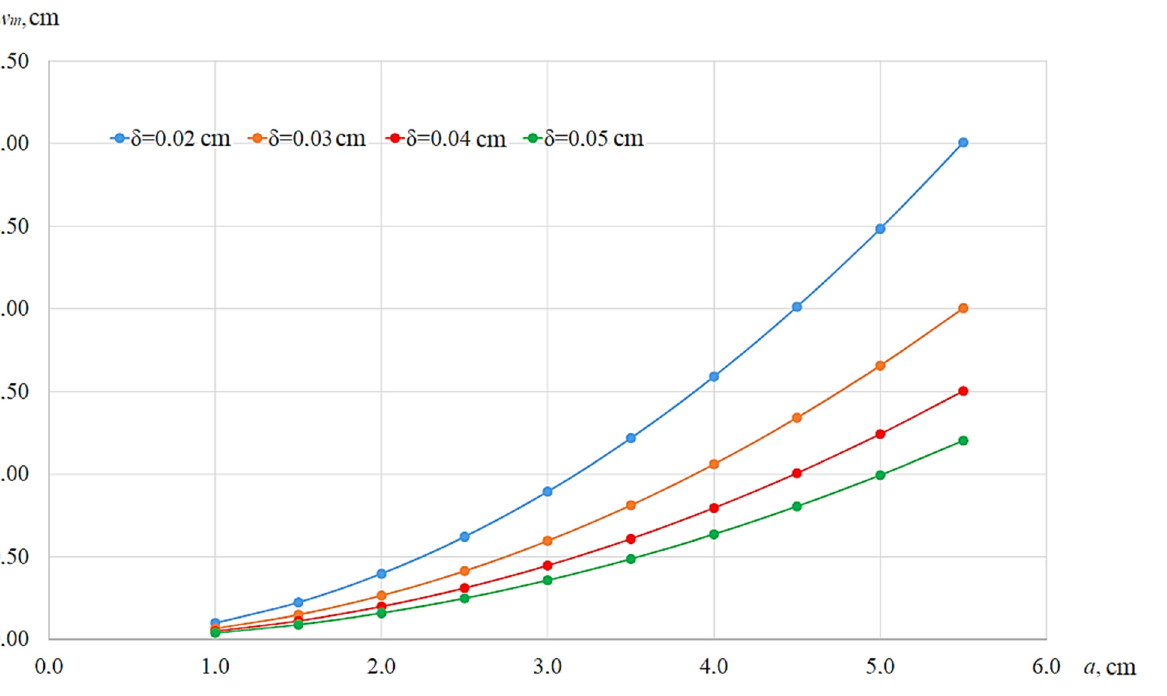
Figure 8. Graph of the dependence of the maximum deflection in the center of the membranes ( w m ) on membrane radius ( a ) and thickness ( δ ).